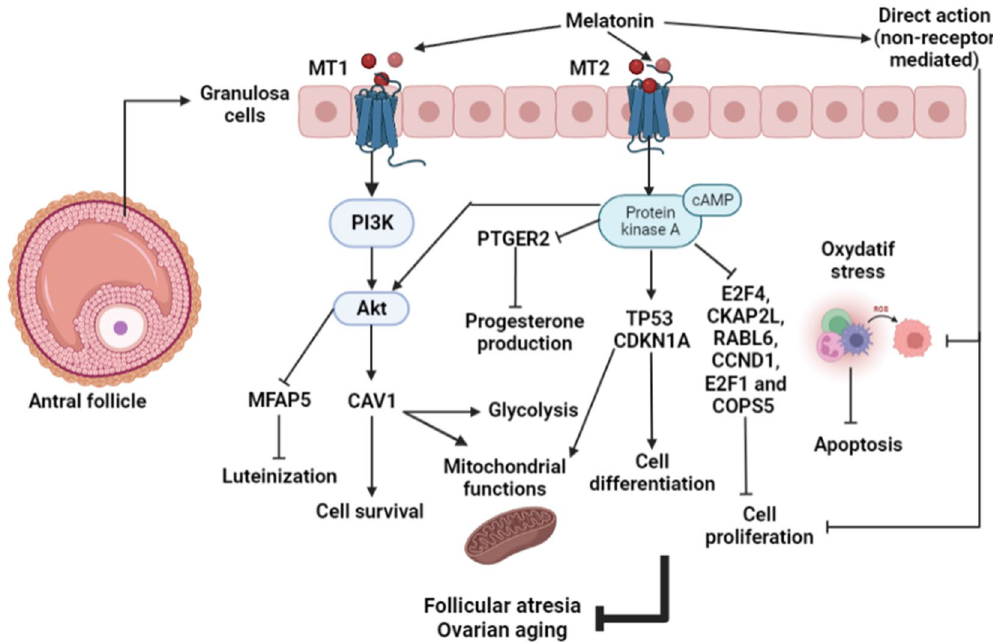
Figure 3. Role of MT1 and MT2 receptors on the genomic response of human granulosa cells to melatonin (generated by BioRender, https:// biore nder.